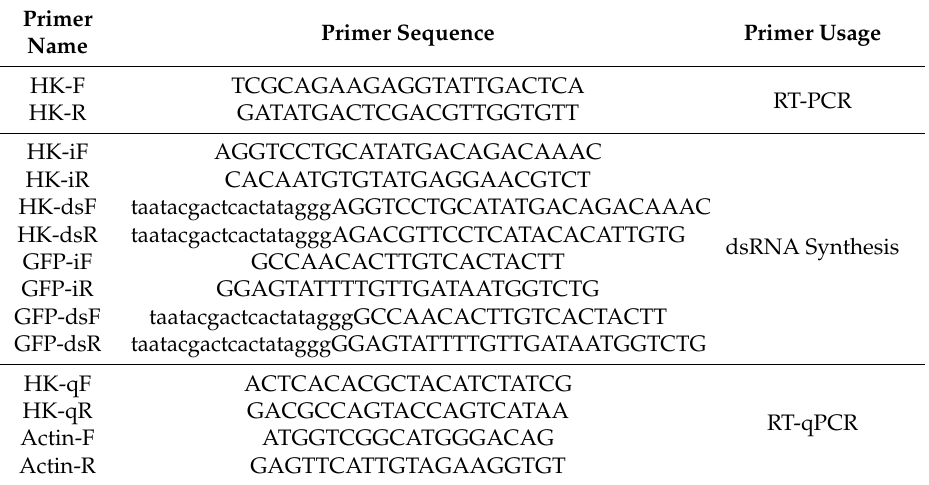
Table 1. Primer information for cloning and expression analysis of CmHK